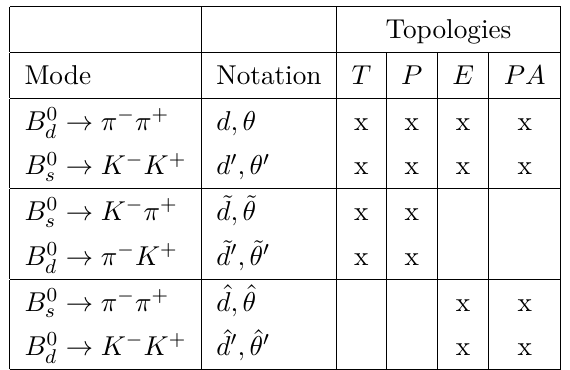
Table 1 . Decay topologies contributing to the different B → hh modes ( h = π, K ) and the notation of the corresponding hadronic